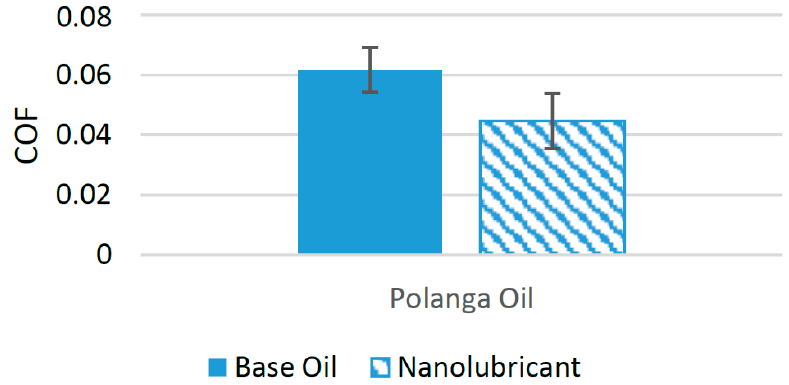
Figure 19. Effect of Alumina (Al 2 O 3 ) NPs on the friction performance of bio-lubricants.